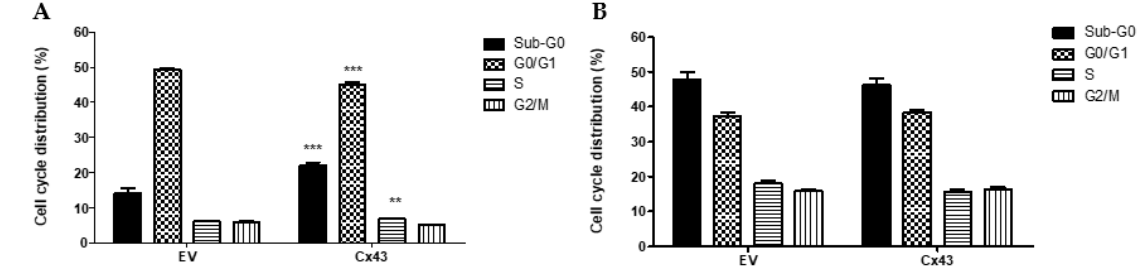
Figure 3. Effect of connexin 43 overexpression in the cell cycle of GH3 and AtT-20 cell lines that were transfected with empty vector (EV) or Cx43. ( A )—Cell cycle distribution of transfected GH3 cells. ( B )—Cell cycle distribution of transfected AtT-20 cells. The data are presented as the mean ± SEM and are representative of at least three experiments that were performed in triplicate, analysis using Mann–Whitney U-test. ** represents very significant differences (0.001 ≤ p < 0.01), *** represents extremely significant differences (0.0001 ≤ p < 0.001), comparing which cycle phase of Cx43 with control (EV).